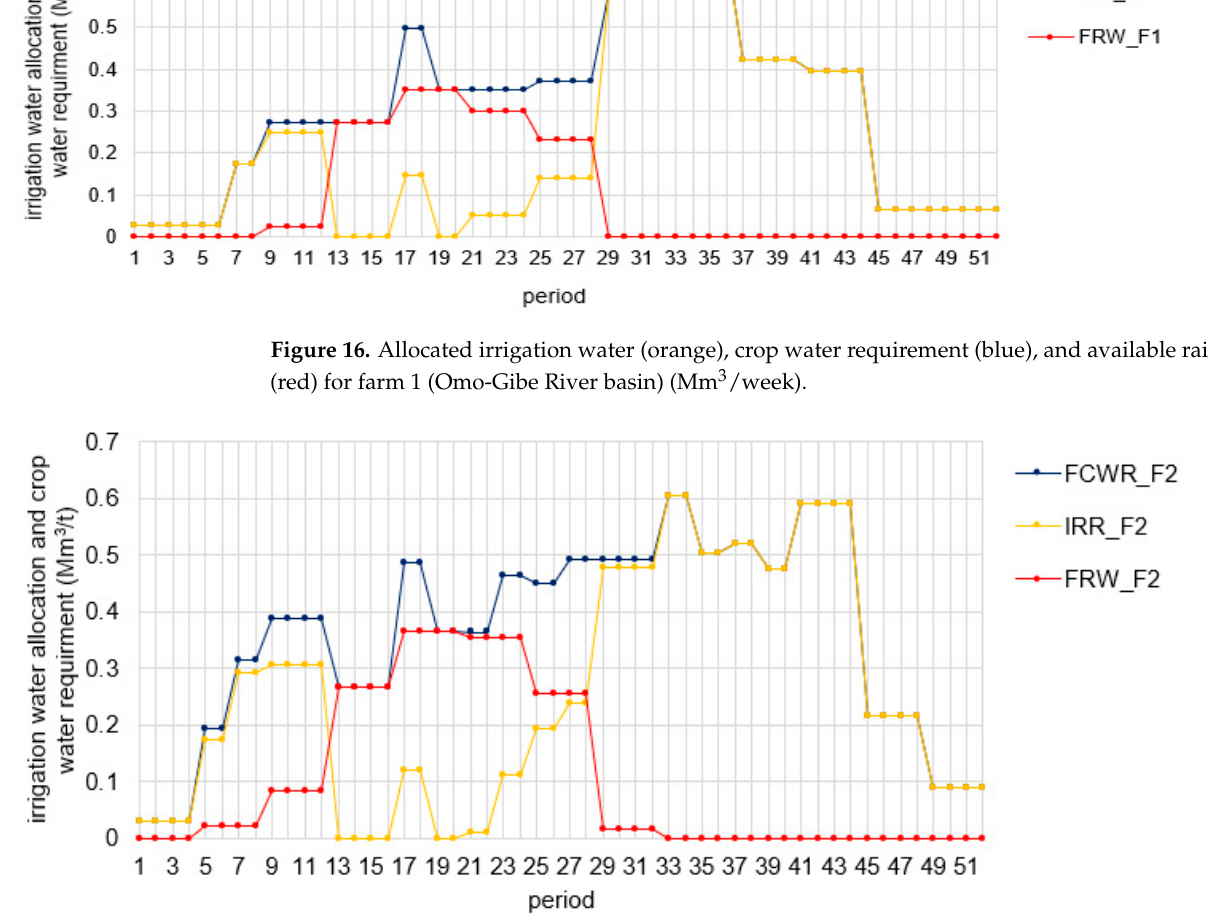
Figure 17. Allocated irrigation water (orange), crop water requirement (blue), and available rainfall (red) for farm 2 (Omo-Gibe river basin)(Mm 3 /week).